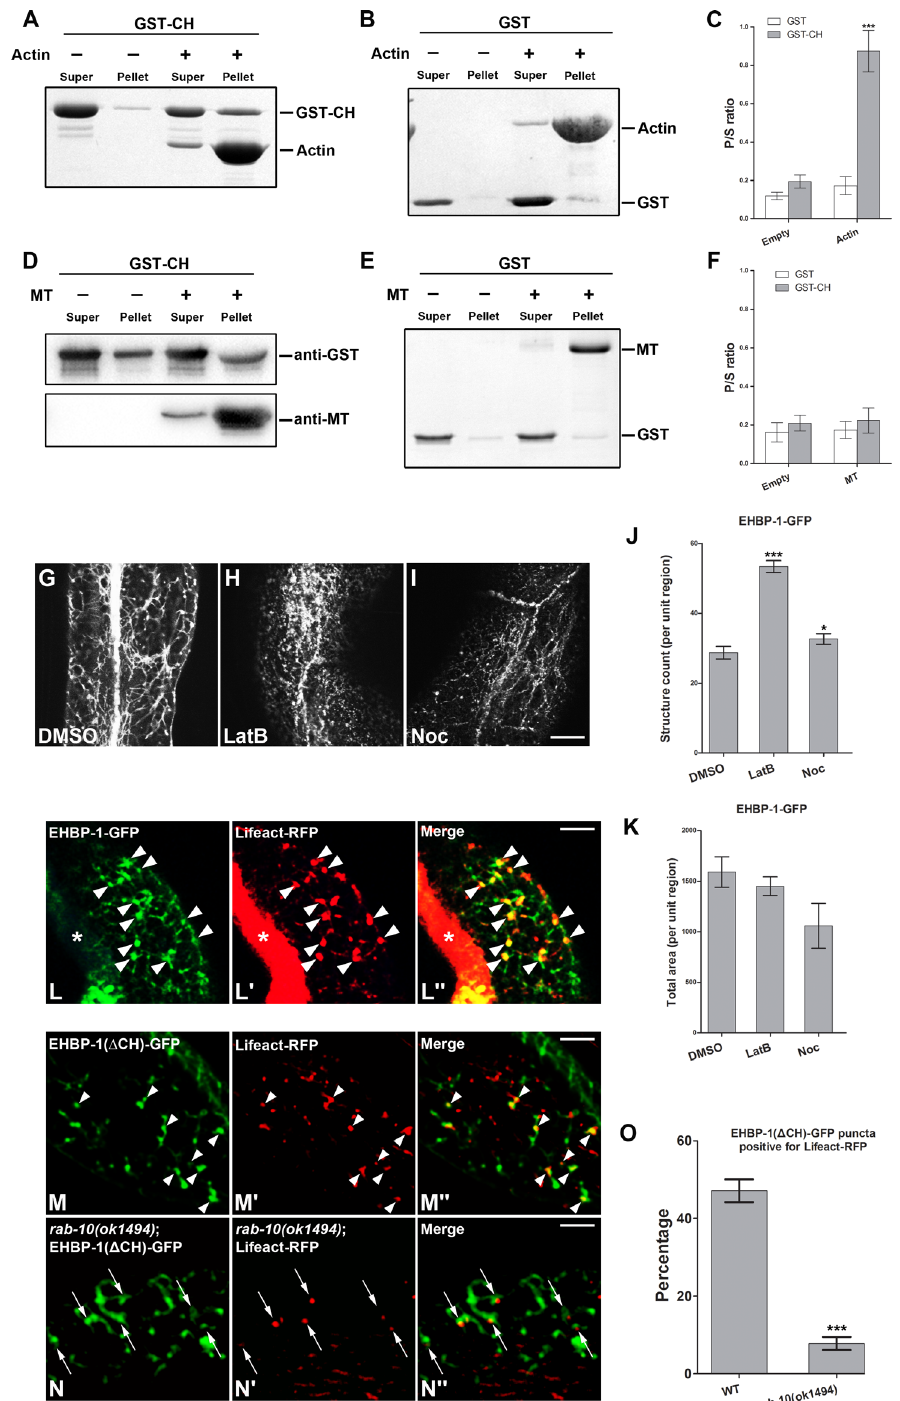
Fig 5. Interaction of the EHBP-1 CH domain with F-actin. (A-B) The EHBP-1 CH domain co-sediments with actin filaments in vitro . GST-CH sedimentation P/S ratio (pellet/supernatant) shifted from ~16% to ~80% with addition of actin filaments (coomassie blue stained gel). P/S ratio was quantified for GST-CH and GST-only in (C) , error bars are SEM (n = 3). Asterisks indicate significant differences in the one-tailed Student ’ s t-test ( *** p < 0.001). (D-E) Compared with the control, microtubule addition did not enhance the sedimentation of GST-CH (anti-GST western blot). P/S ratio was quantified for GST-CH and GST-only in (F) , error bars are SEM (n = 3). (G-K) Integrity of EHBP-1 positive tubular endosomes requires intact F-actin